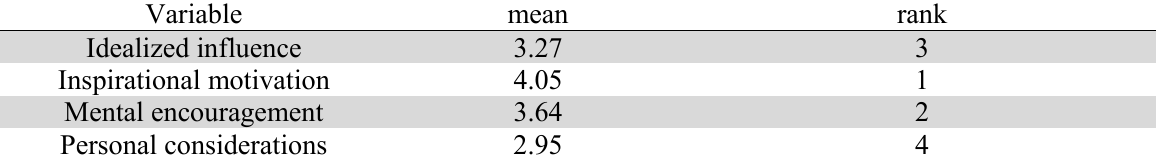
Ranking and importance of the dimensions of transformational